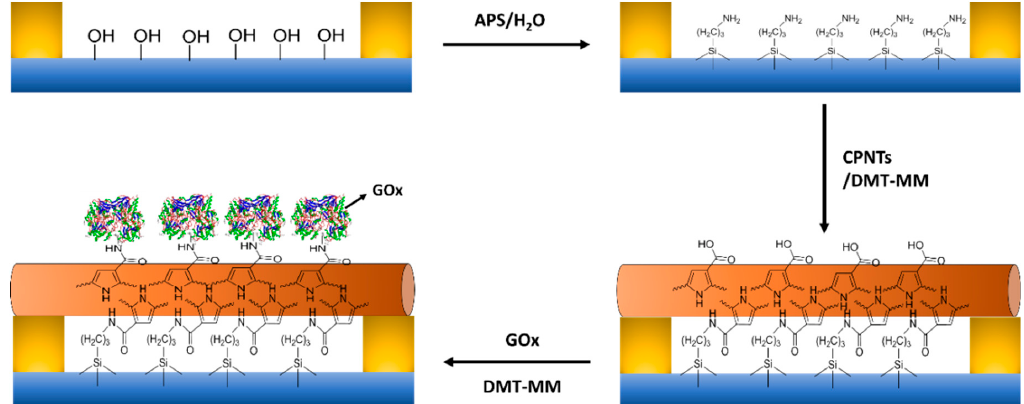
Figure 4. Schematic diagram of reaction steps for the fabrication of polypyrrole nanotube-based